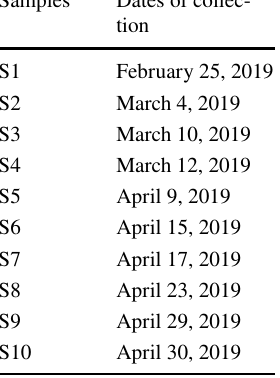
Samples Dates of collec-